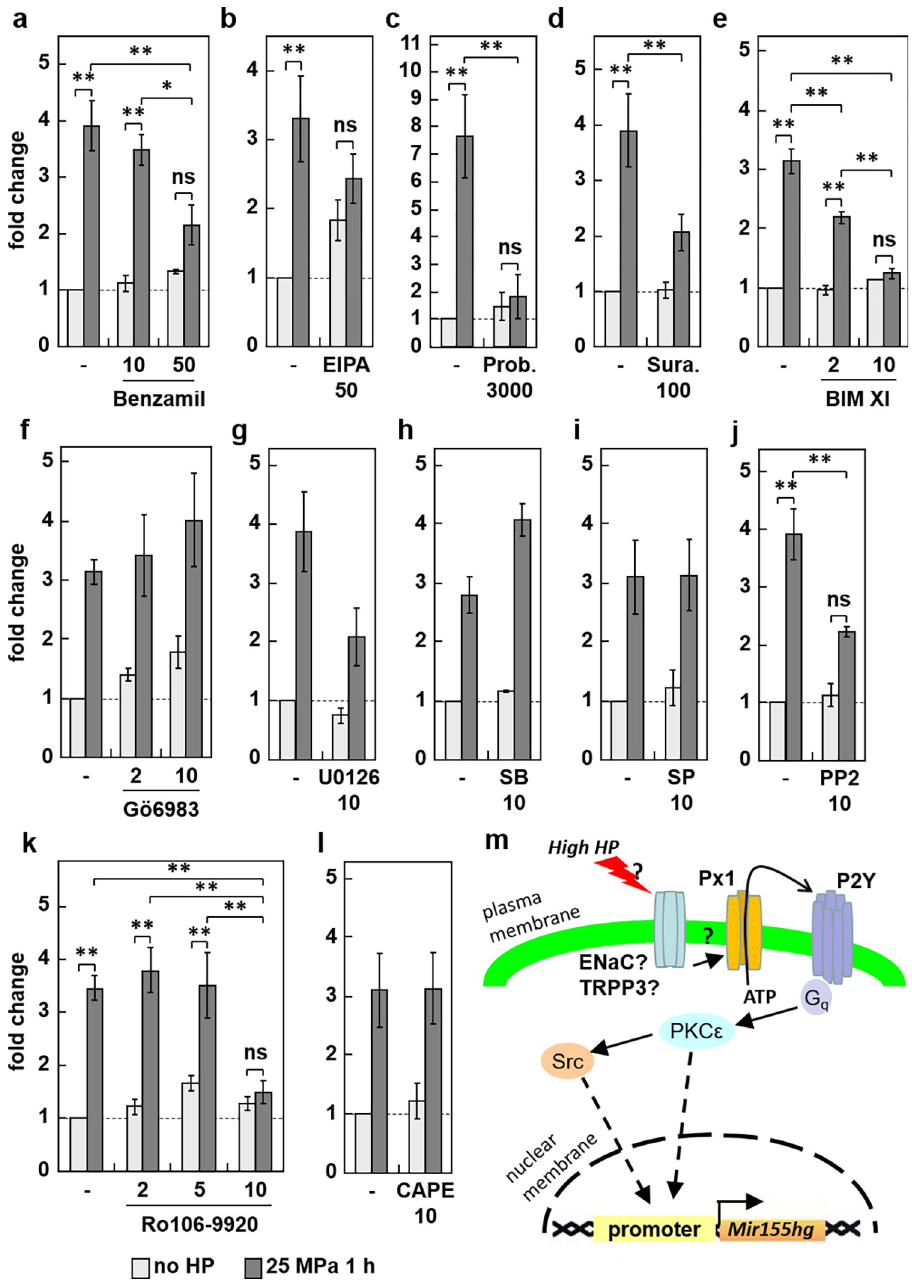
Fig 3. Effect of various signaling inhibitors on the Mir155hg up-regulation by HP. ATDC5 cells were pre-treated with a) the ENaC channel and sodium-calcium exchanger inhibitor benzamil, b) the TRPP3 channel inhibitor EIPA, c) the pannexin-1 inhibitor probenecid (Prob.), d) the broad G protein inhibitor suramin (Sura.), e-f) the PKC inhibitors bisindolylmaleimide XI (BIM XI) or Go¨6983, g-i) the ERK1/2, p38 or JNK MAP kinase inhibitors U0126, SB203580 (SB) or SP600125 (SP), j) the Src inhibitor PP2, or k-l) the NF- κ B inhibitors Ro106-9920 and CAPE at the indicated concentrations (in μ M). After this pre-treatment, the cells were pressurized, or not, for 1 h under 25 MPa. Mir155hg expression was then measured by real-time PCR. The graphs show the mean +/- SEM of at least three independent experiments. Statistical significance was assessed by performing a two-way ANOVA followed, only when the ANOVA p-value was < 0.05, by Tukey’s HSD, the asterisks indicate the statistical significance of the differences between the indicated conditions: � :p < 0.05, �� :p < 0.01) schematic diagram of the possible mechanotransduction pathway leading from HP mechano-sensing to Mir155hg